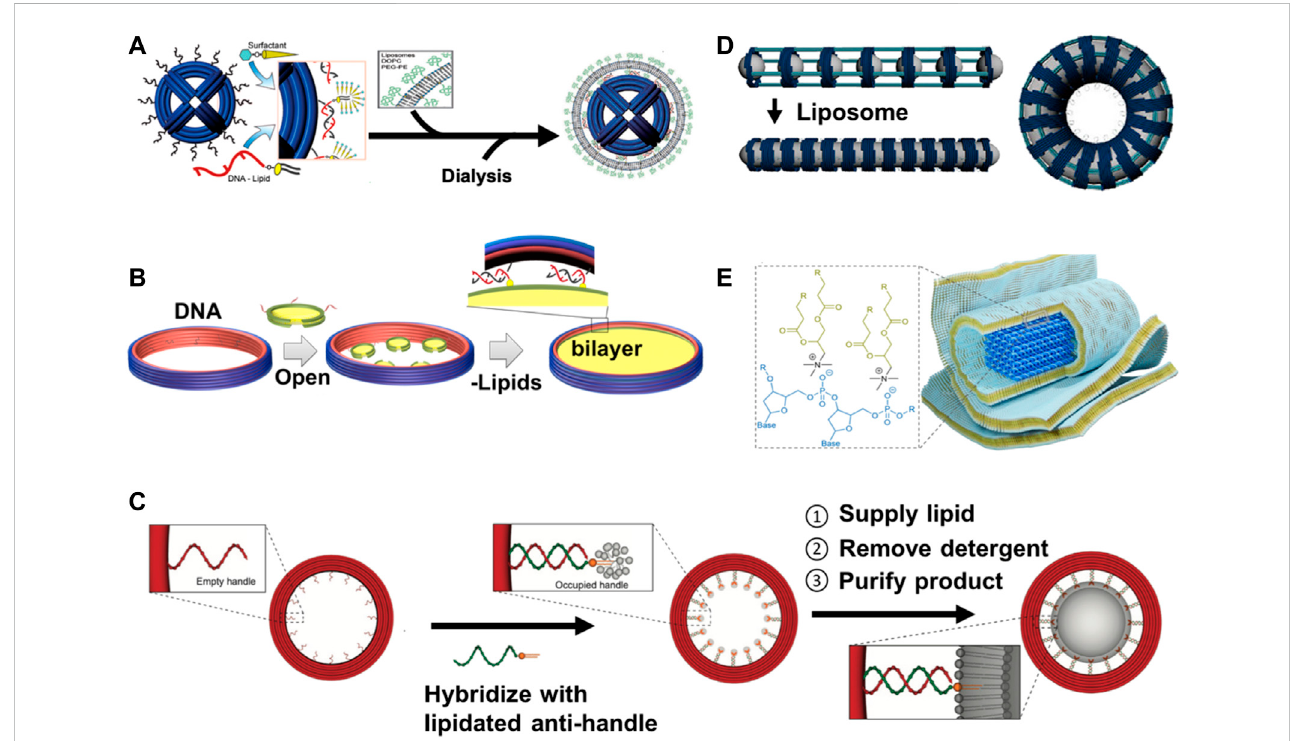
FIGURE 3 Schematic illustration of DNA nanostructures templated the formation of curved (liposomes) and planar (nanodiscs) lipid-bilayer membranes. (A) DNA- origami spheres can be used as inner (endoskeleton) templates for constructing liposomes around spheres via outer DNA handles annealed to anti-handle lipid conjugates ( fi gure used with permission from Perrault and Shih 2014). (B) DNA-origami barrels can be fi rst decorated by small nanodiscs (oligo- conjugated) via DNA hybridization, incubated with excess liposomes and detergents, dialyzed, and fi nally puri fi ed by sucrose-gradient centrifugation to reconstitute large-sized DNA-corralled nanodiscs ( fi gure used with permission from Zhao et al., 2018). (C) DNA-origami rings can be used as outer (exoskeleton) templates for forming size-controlled liposomes inside the rings through handle and anti-handle assembly ( fi gure used with permission from Yang et al., 2016). (D) DNA-origami nanocages were externally templated for the formation of shape-de fi ned liposomes arranged in arrays to make width- de fi ned membranetubulesand toroidal liposomesto mimic lipid-bilayermembrane curvatures(elongation, bending, and twisting) present inthe cells ( fi gure used with permission from Zhang et al., 2017). (E) DNA-origami helix bundle can be used as endoskeleton templates for growing of multilamellar lipid structures through electrostatic interactions between the positively charged headgroup of the lipid molecules and the negatively charged phosphate groups in the DNA backbone ( fi gure used with permission from Julin et al.,